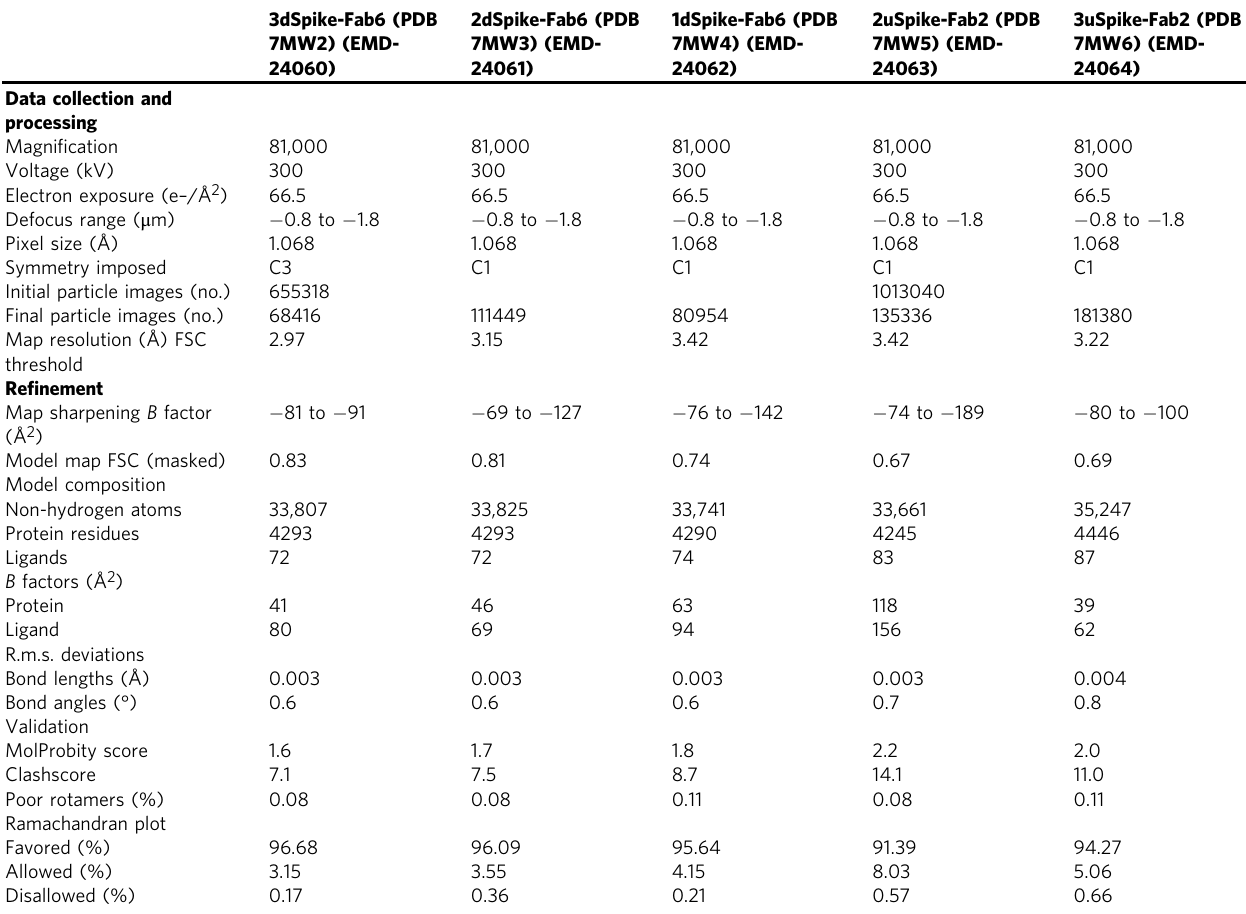
Table 1 Cryo-EM data collection and re fi nement